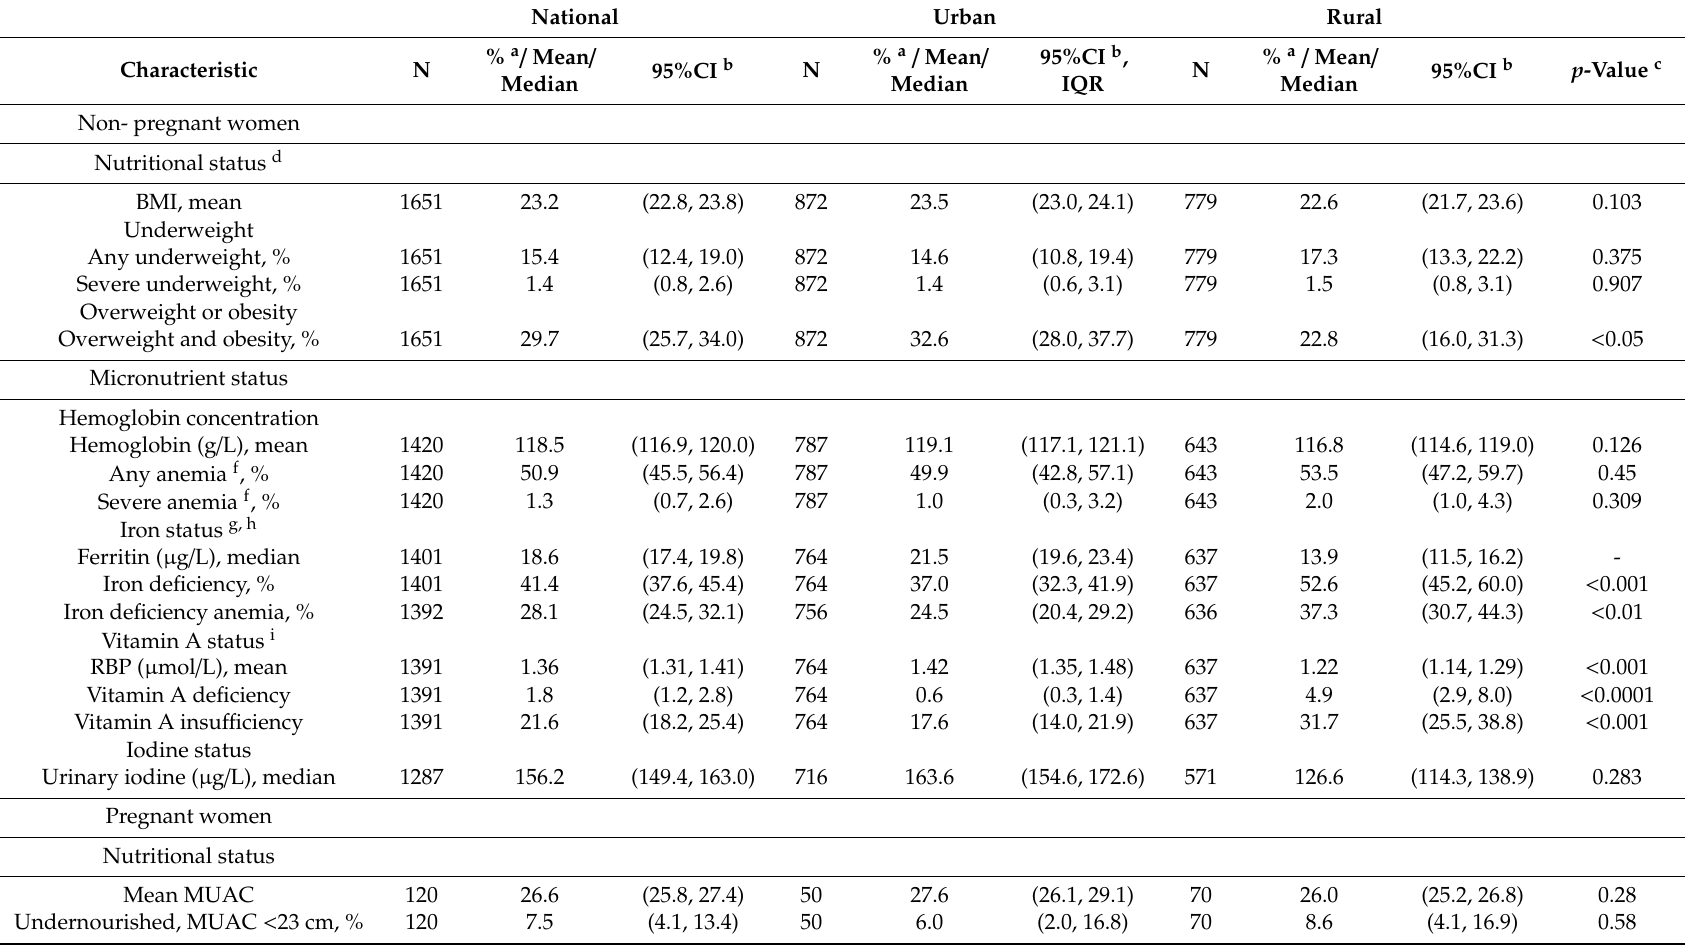
Table 4. Micronutrient and anthropometric indicators of women, The Gambia 2018.